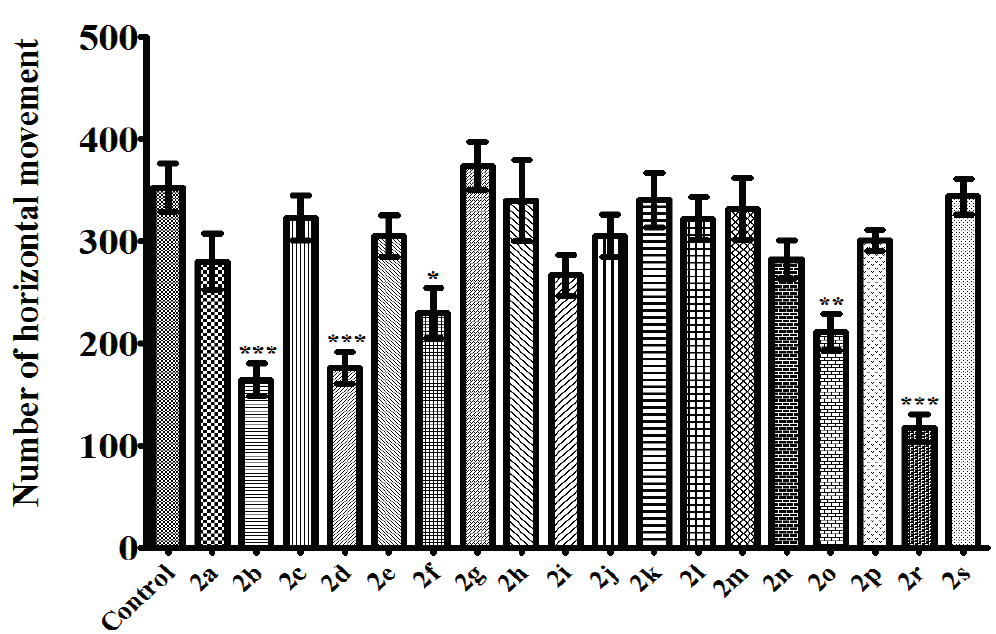
Figure 5. Effects of test compounds (100 mg/kg) on the number of horizontal movement of mice in the activity cage test. Significance against control values * p < 0.05, ** p < 0.01, *** p < 0.001. Values are given as mean ± SEM. One-way ANOVA, post-hoc Tukey’s test, n = 7.